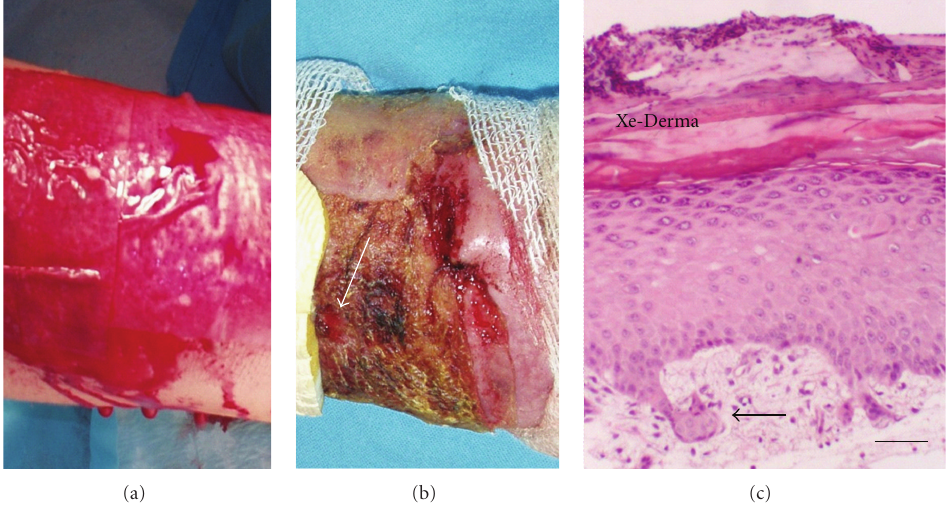
Figure 4: Xe-Derma used to cover areas after necrectomy to prepare the wound for autografting. (a) Temporary cover of an area after necrectomy originally evaluated as 3rd degree burn. XD was adhered immediately and stopped bleeding instantly. (b) XD incrusted by fibrin absorption (arrow—the point of biopsy on day 8). (c) Histology taken on day 8 showed fully di ff erentiated epidermis without or with low development of rete ridges (arrow). Bar—50 μ